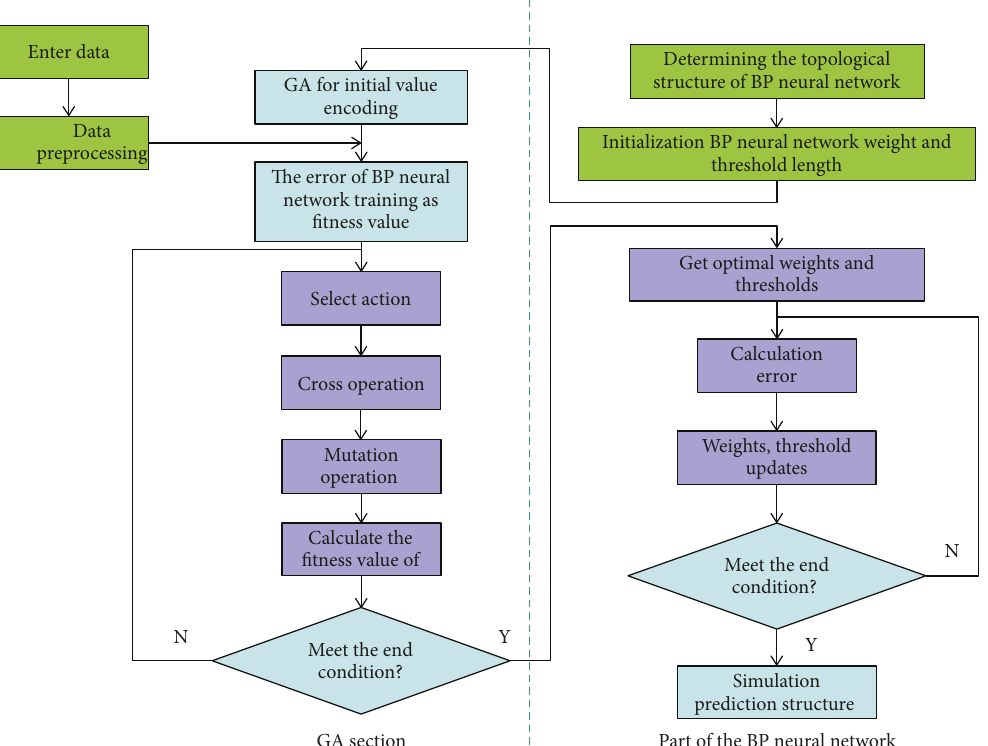
Figure 6: Flowchart of the genetic